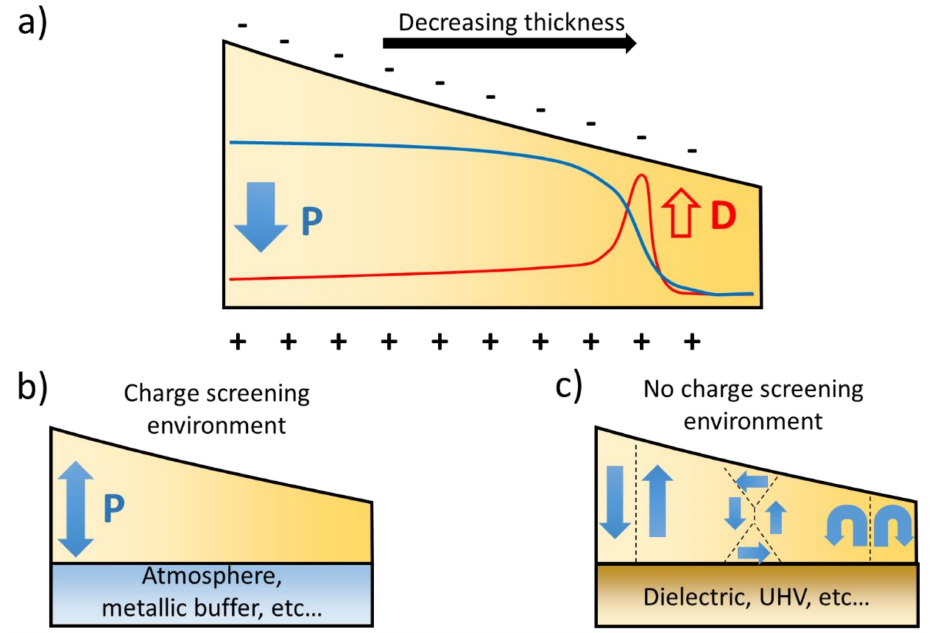
Figure 1. Thickness dependence of the polar state in ferroelectric thin films. ( a ) The polarization P and depolarizing field D have a thickness dependence, resulting in the minor influence of the depolarizing field on polarization in the high thickness range and a suppression of polarization at low thicknesses; ( b ) When the bound charges can be screened by the environment, the depolarizing field is minimized and a single domain state can be stabilized over a wide thickness range; ( c ) In the absence of charge screening, however, the depolarizing field favors a multi-domain state. Flux closure or vortices can also form in a specific thickness or strain